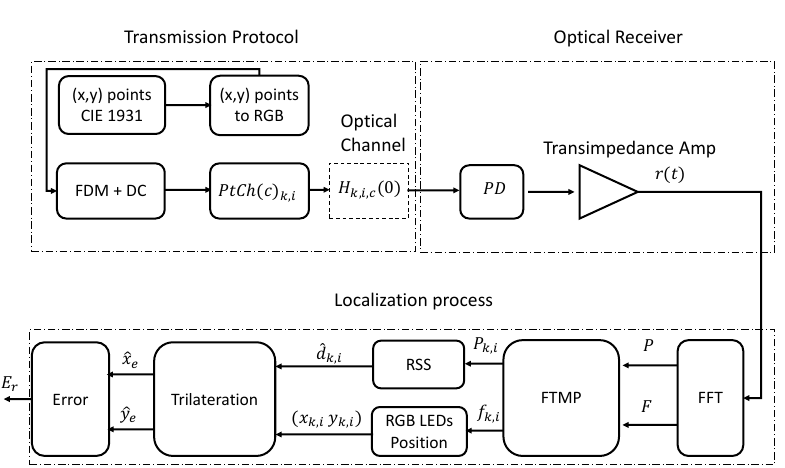
Figure 2. Muti-cell architecture of the proposed VLP system based on RGB LEDs.